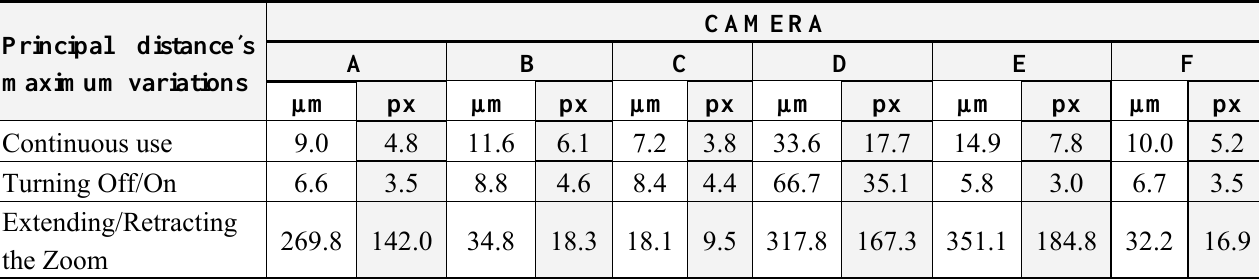
Table 3. Maximum variations of the principal distance, obtained from the six cameras tested in the 20 modeling